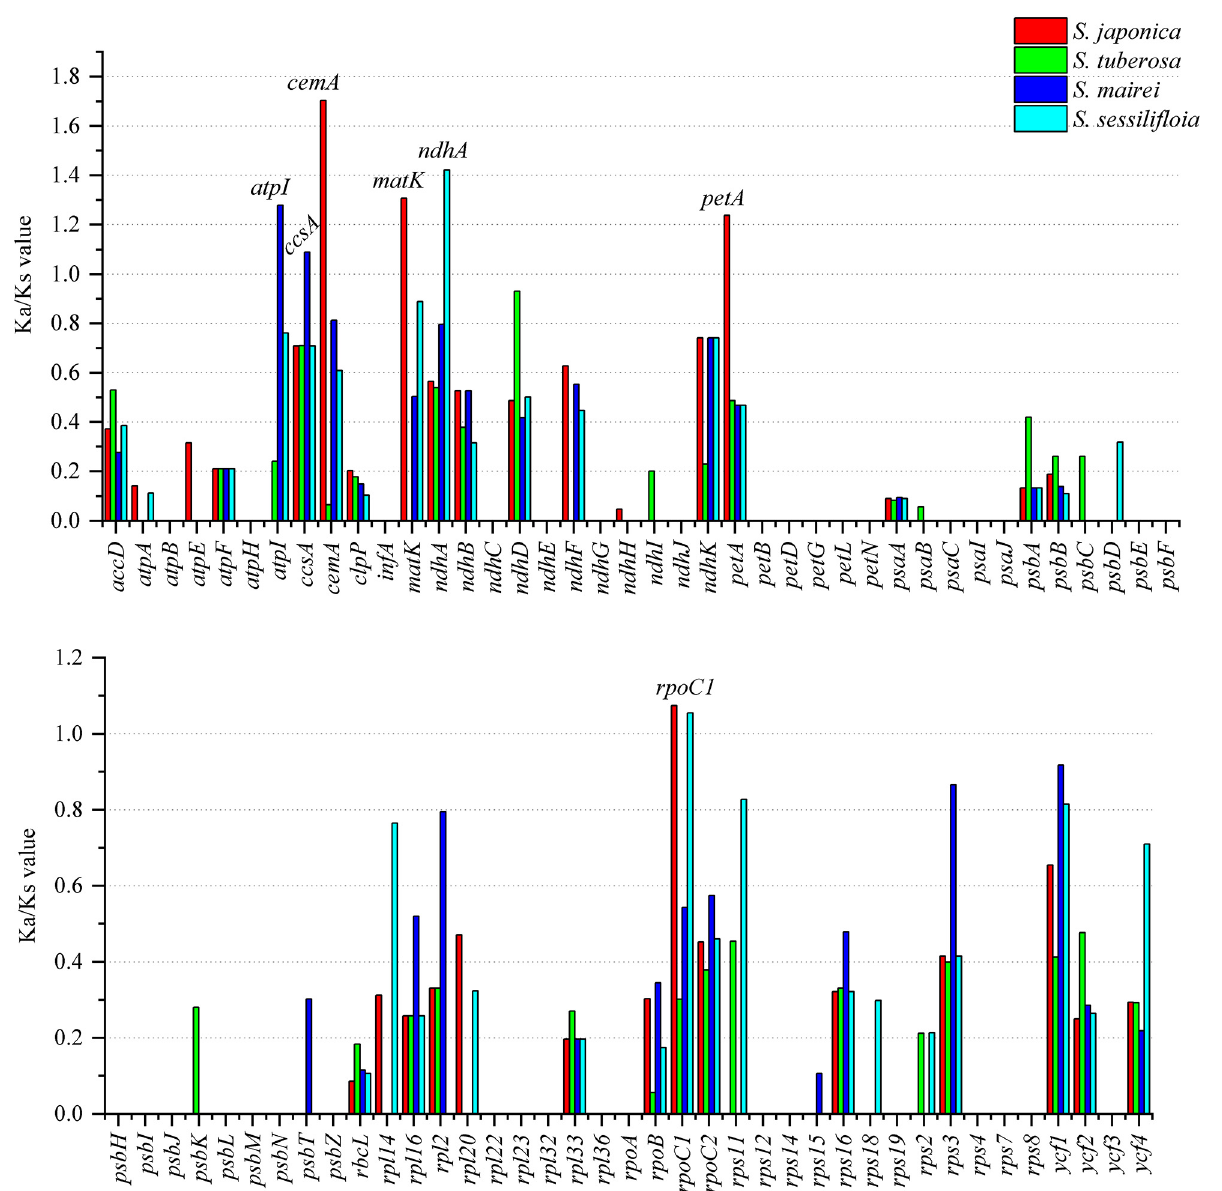
Figure 6. Detection of positive selection sites of chloroplast genes in Stemona , with S. parviflora as a reference genome.